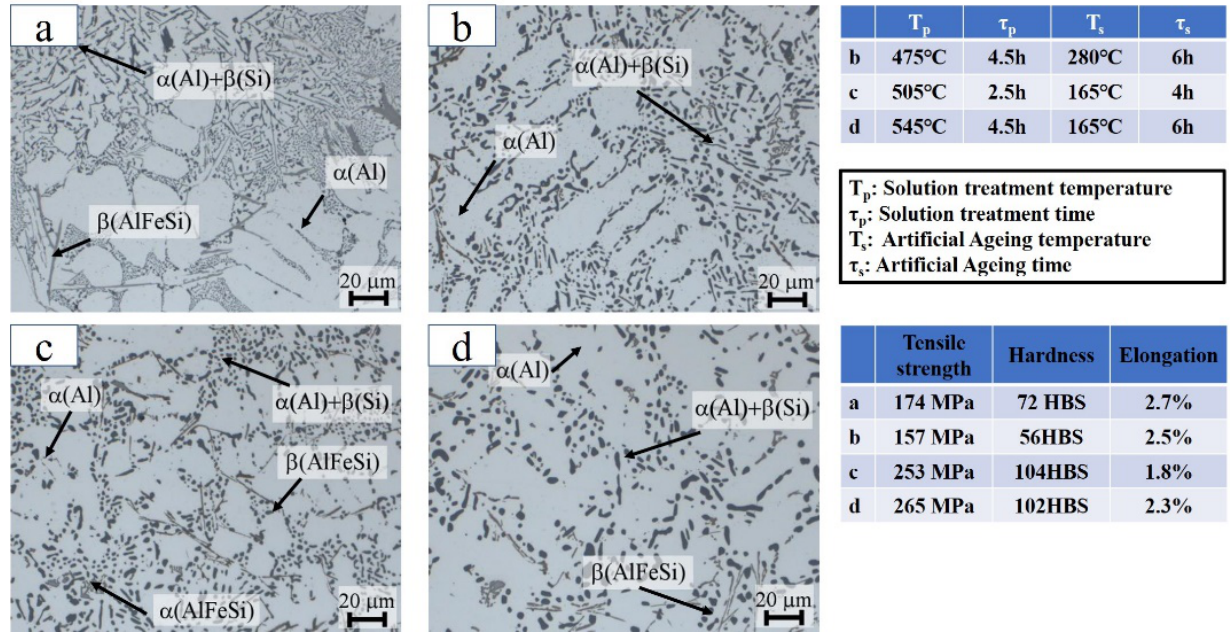
Figure 10. EN AC-AlSi11(Fe) alloy microstructure in the ( a ) initial state and after T6 heat treatment ( b – d ) [58].